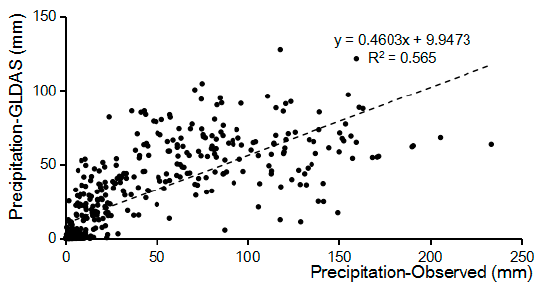
Figure 7. Correlation coefficient between Global Land Data Assimilation System (GLDAS) and observed precipitation data.